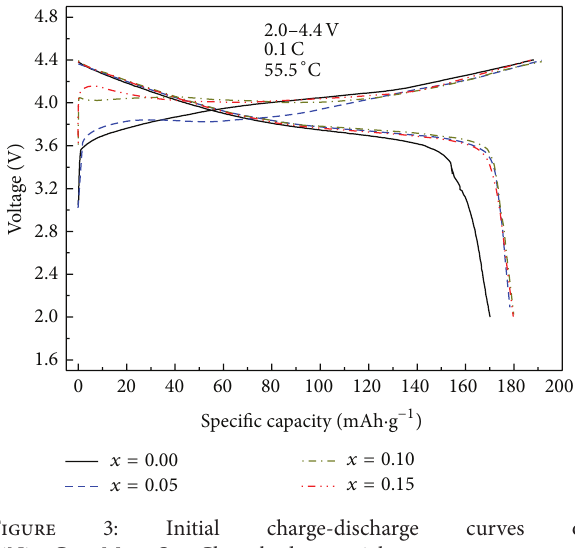
3: Initial charge-discharge curves of LiNi 1/3 Co 1/3 Mn 1/3 O 2−𝑥 Cl 𝑥 cathode